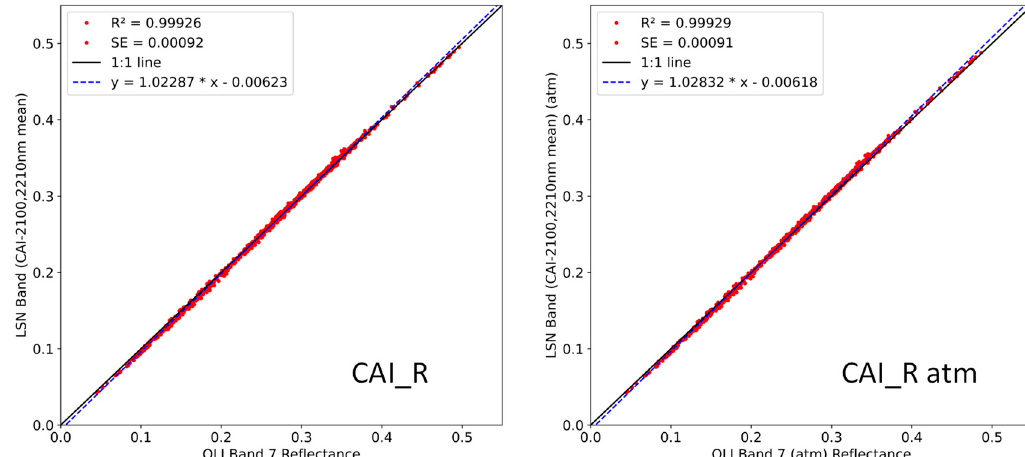
Figure 13. Spectral reflectance for calculated OLI Band 7 (2200 nm center, 180 nm bandwidth) compared to the convolution of proposed Landsat Next bands, with high R 2 , low standard error (SE) and slopes nearest to 1.000 indicating the best mission continuity. The various two- and three-band convolutions displayed here are associated with the Shortwave Infrared Normalized Difference Index (SINDRI), the Lignin-Cellulose Peak Centered Difference Index (LCPCDI), and the two rightmost (longest-wavelength) bands of the Cellulose Absorption Index (CAI_R), calculated from original gaussian surface reflectance spectra, as well as from gaussian spectra transformed to include simulated residuals of atmospheric correction and sensor noise (atm).